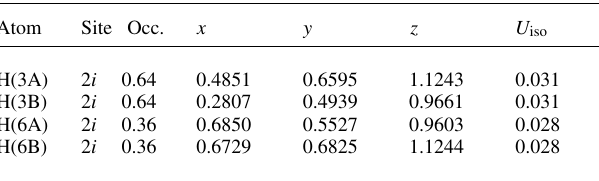
Table 2. Atomic coordinates and displacement parameters (in Å 2 )